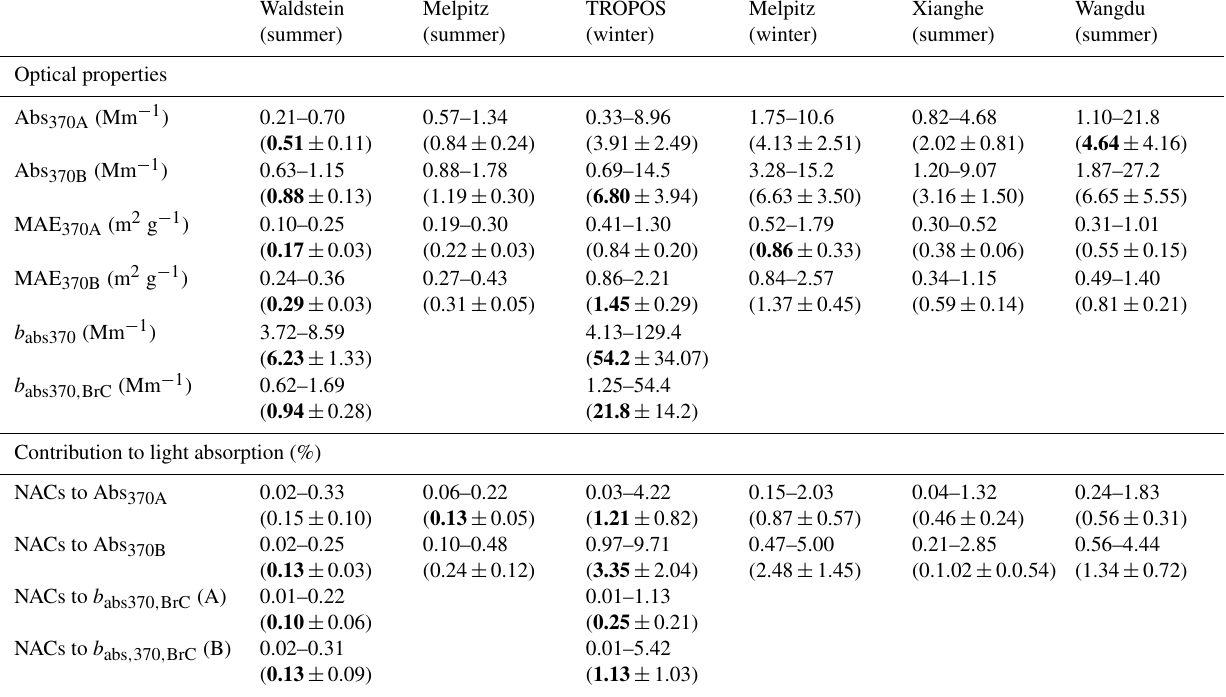
Table 2. Optical properties and calculated contribution of NACs to the light absorption of aqueous extracts and particulate BrC. The values are given as minimum–maximum (mean ± standard deviation). Acidic conditions are indicated by the letter “A” and alkaline conditions are indicated by the letter “B”. Highest and lowest mean values for each category are marked in